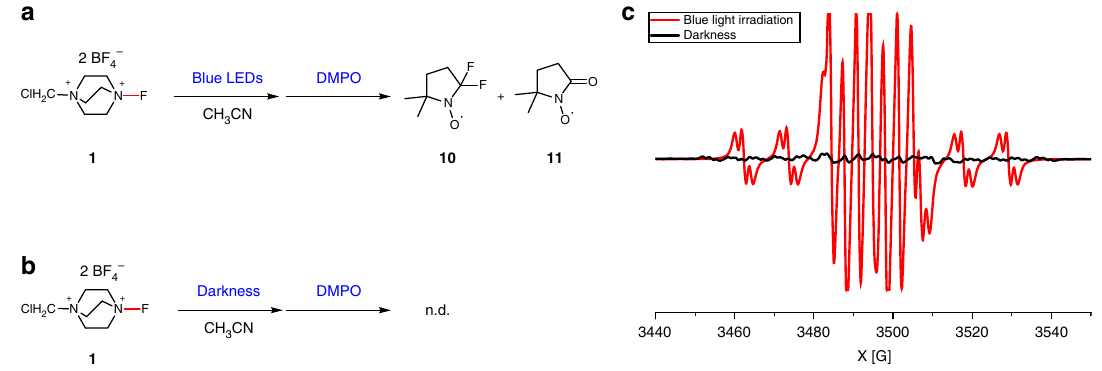
Fig. 4 The electron paramagnetic resonance (EPR) experiments. a The EPR experiment of select fl uor under blue light irradiation. b The EPR experiment of select fl uor under darkness. c The EPR spectra of select fl uor under blue light irradiation and